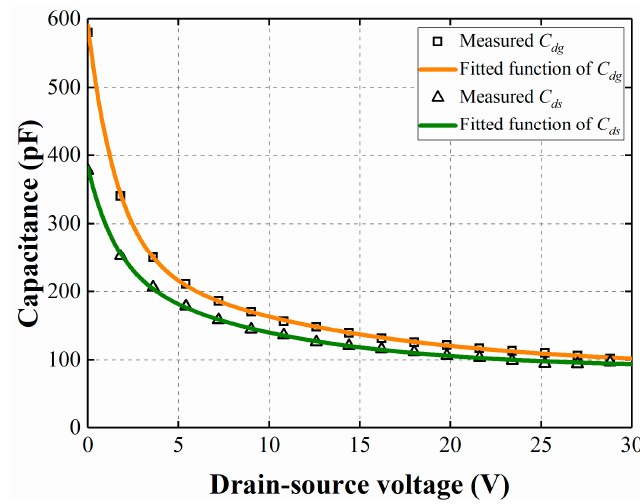
Figure 4. Comparison between measurement and modeling of the nonlinear capacitances of the power MOSFET.